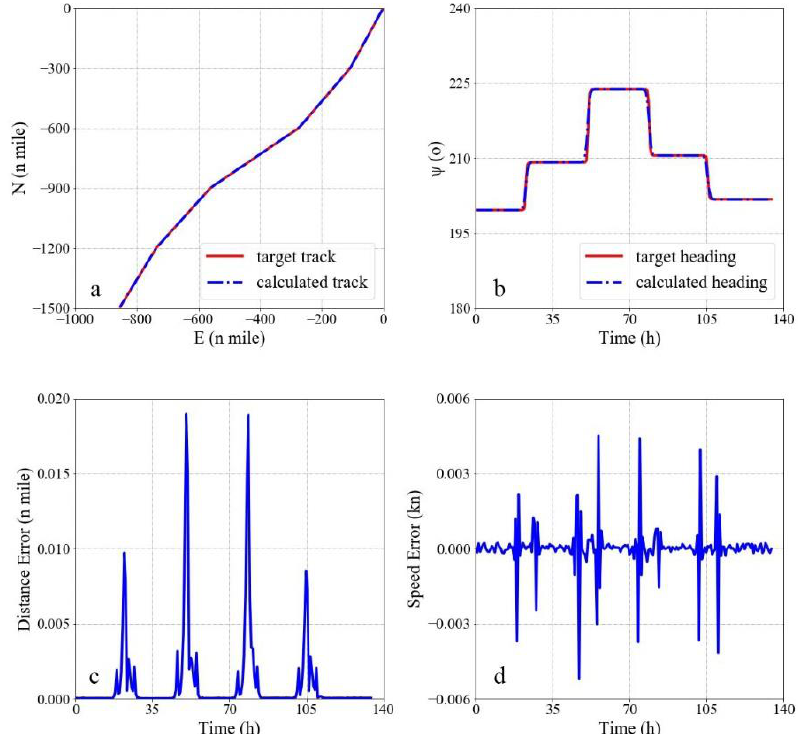
Figure 3. Results of sailing in the still water scenario. ( a ) Comparison of the track, ( b ) comparison of heading, ( c ) distance error, and ( d ) speed error.